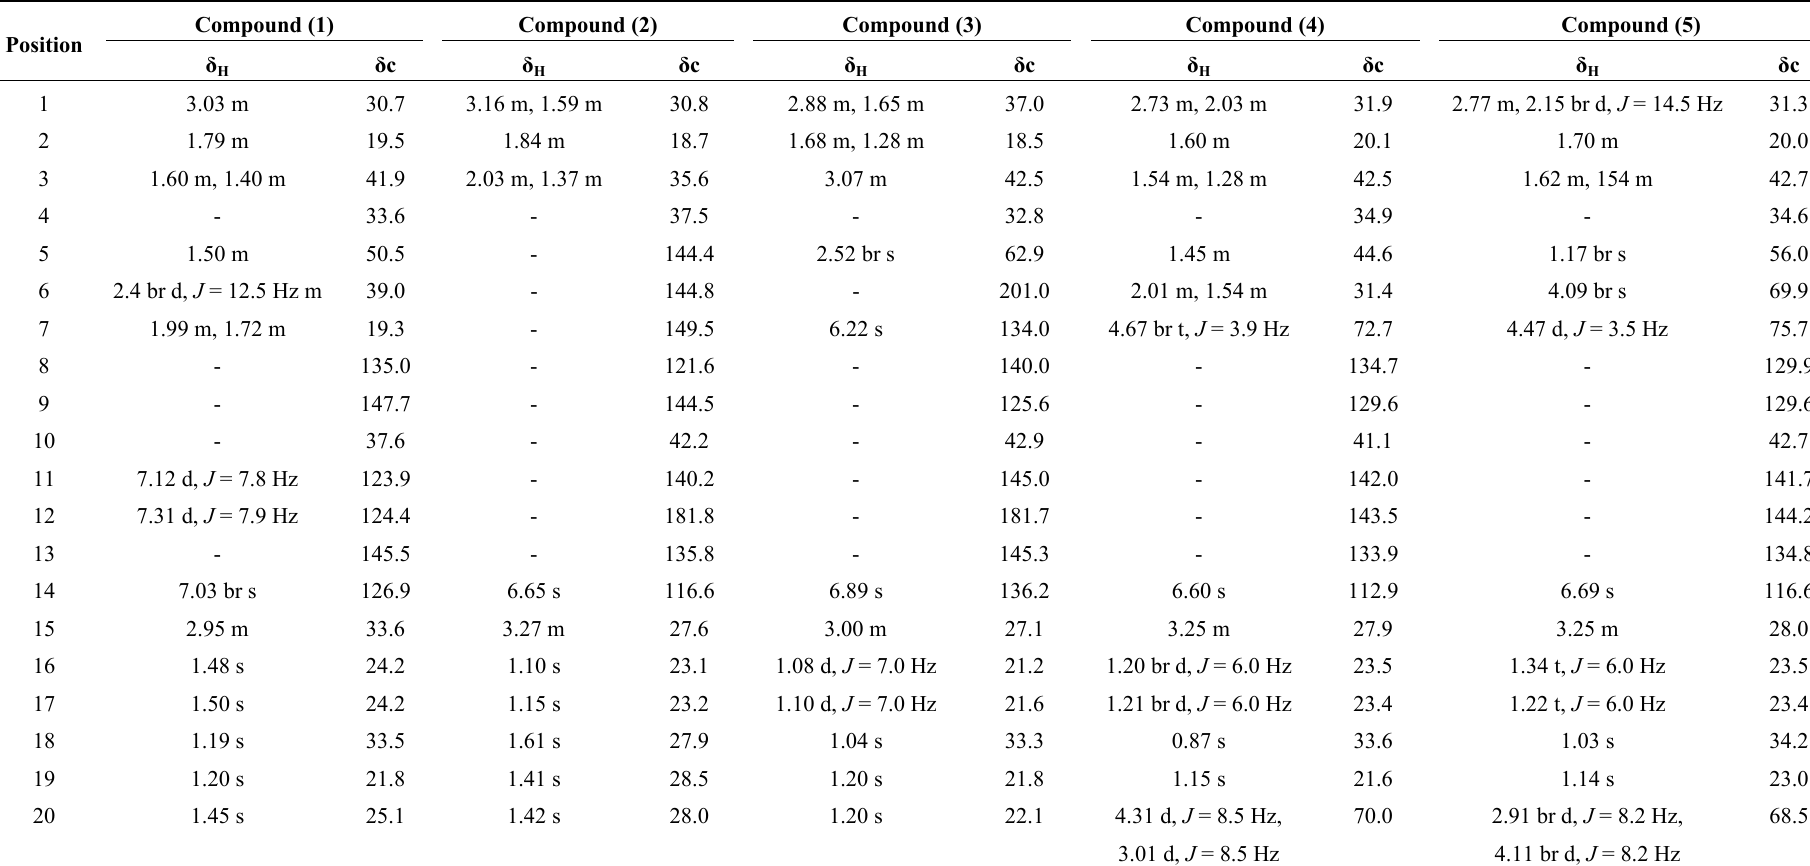
and ( 2 ), ( 4 ), ( 5 ) in CD 3 3